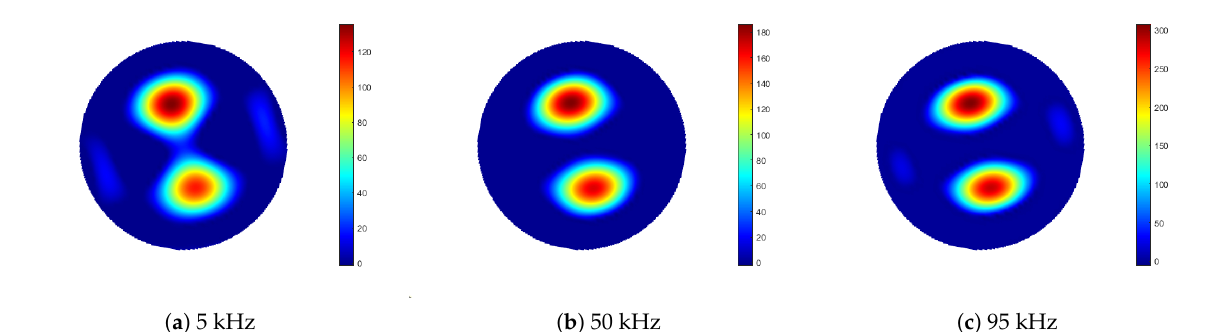
Figure 8. Reconstructed images from aluminium external object inclusion measurements ( ∆ V = V both − V bg ), acquired using 5, 50 and 95 kHz excitation field frequencies. Images represent a circular sample space of 105 mm